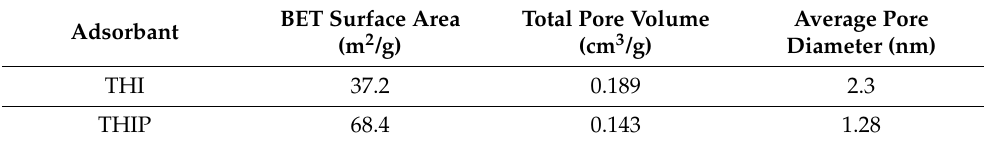
Table 1. THI and THIP characteristics; surface area and pore